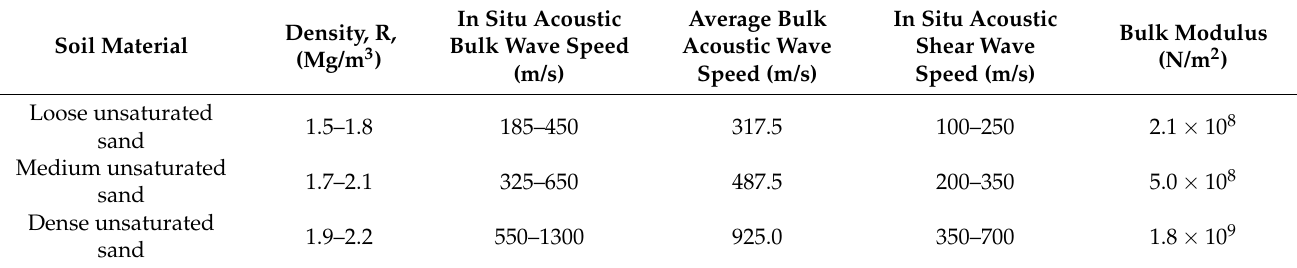
Table 6. Typical values for in situ bulk and shear acoustic wave speeds [29].